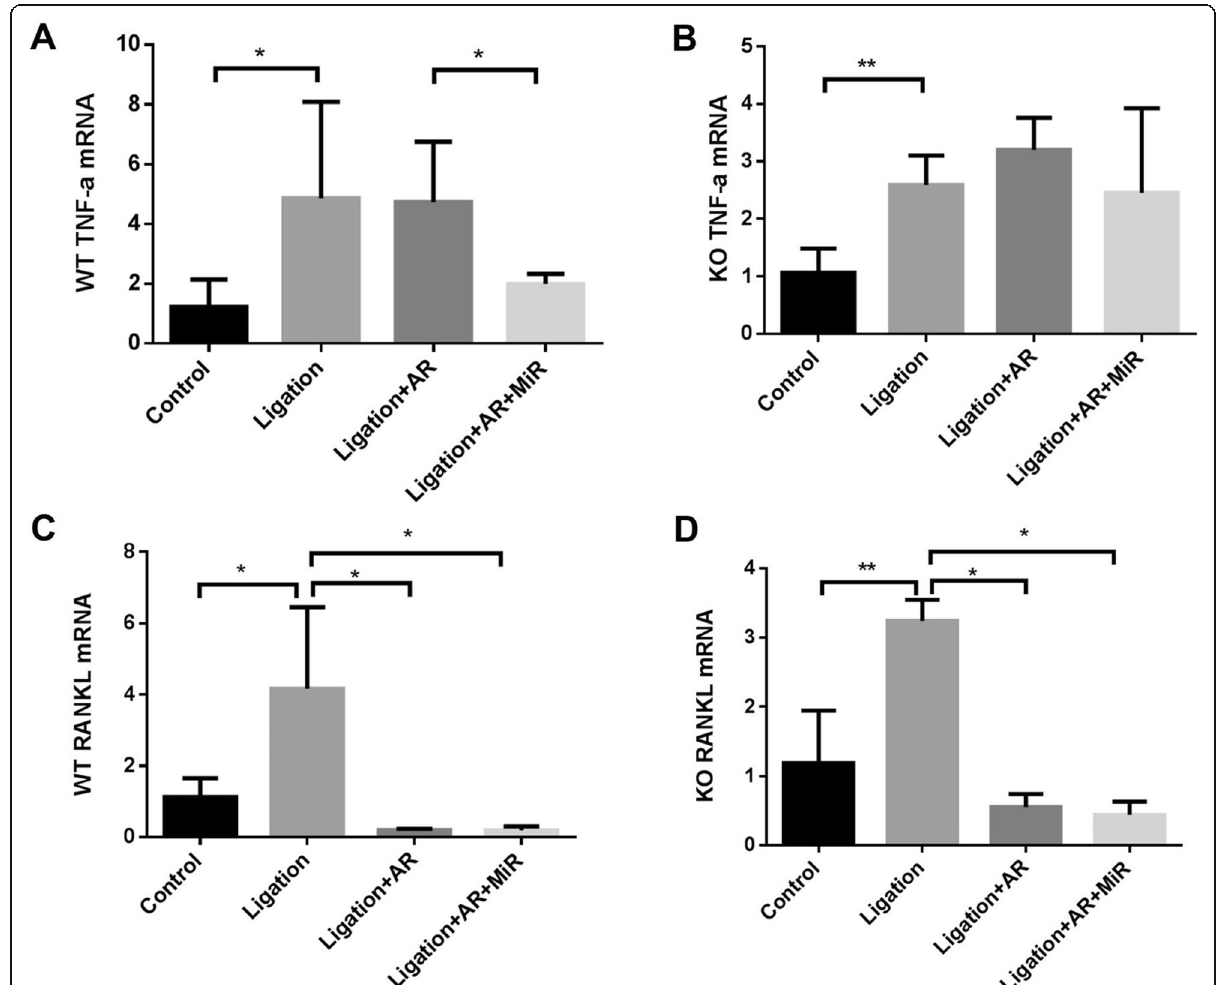
Fig. 5 Anti-RANKL and anti-RANKL+miR-146a treatments decreased gingival mRNA expression of TNF- α and RANKL with different patterns in experimental peri-implantitis of WT and TLR2/4 KO mice. Gingival tissues around ligatured implants and non-ligation implants were excised and processed for RT-qPCR analysis to determine mRNA level of TNF- α of WT mice ( a ) and TLR2/4 KO mice ( b ) (mean ± SD, n = 6, * p < 0.05, ** p < 0.01) and mRNA level of RANKL of WT mice ( c ) and TLR2/4 KO mice ( d ) (mean ± SD, n = 6, * p < 0.05, ** p <